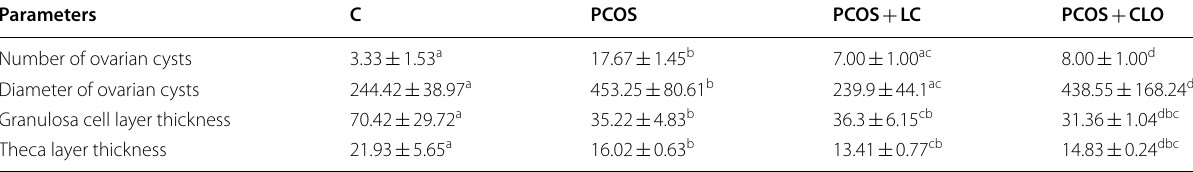
a,b,c,d Means with different superscripts within the same row differ significantly at P < 0.05. No cysts observed in the control group, so all data related to normal ovarian follicles